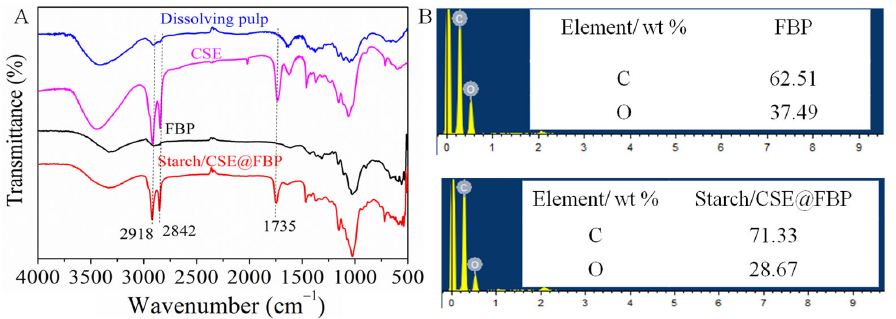
Figure 2. ( A ) FTIR spectra of dissolving pulp, CSE, FBP, and OS/CSE@FBP; ( B ) EDS spectra of FBP and OS/CSE@FBP.